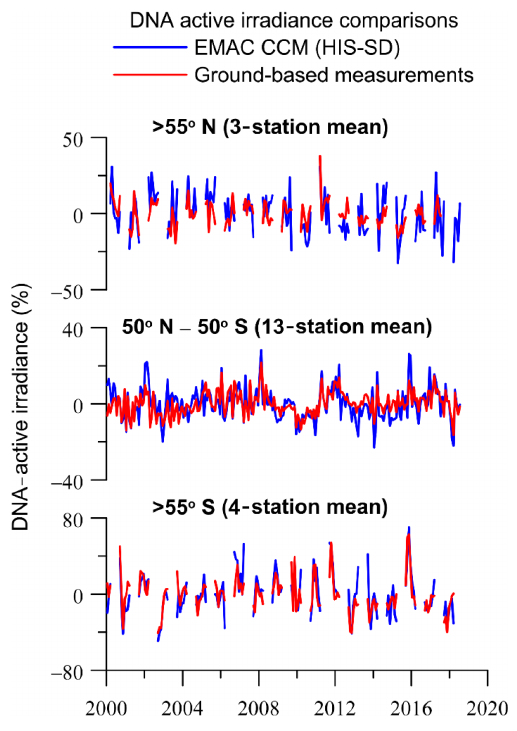
Figure 1. Comparison of model simulations of DNA-active irradi- ance with averages of ground-based measurements at 3 UV stations in the northern high latitudes ( > 55 ◦ N) (upper panel), 13 UV sta- tions from 50 ◦ N to 50 ◦ S (middle panel), and 4 UV stations in the southern high latitudes ( > 55 ◦ S) (lower panel). The y axis shows monthly de-seasonalized DNA-active irradiance data (in %). The monthly data at each station were de-seasonalized by subtracting the long-term monthly mean (2000–2018) pertaining to the same calendar month and were expressed in percent. Then, the average over each geographical zone was estimated by averaging the de- seasonalized data of the stations belonging to each geographical zone. Shown are data from March to September for the northern high latitudes and from September to March for the southern high